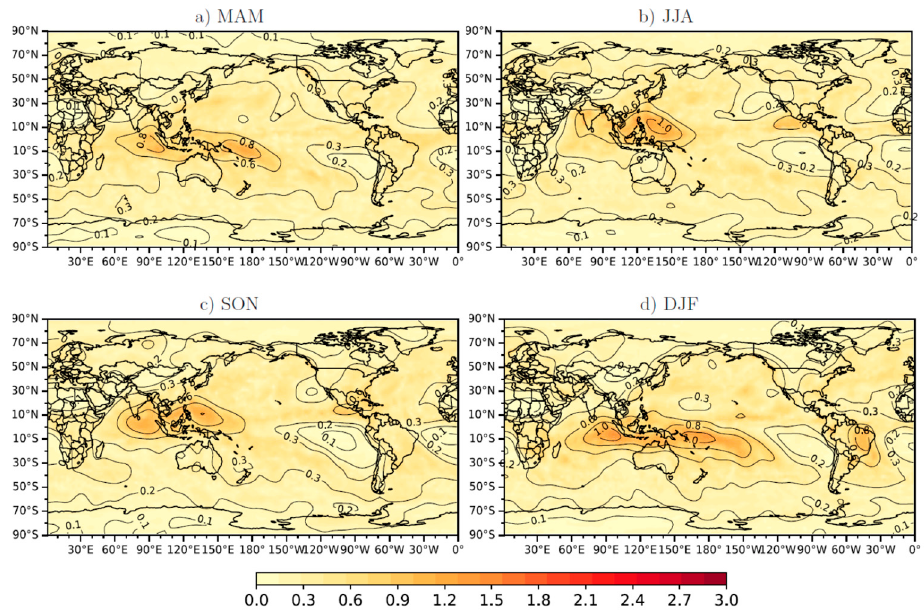
Figure 3. Unpredictable component standard deviation of GPCP precipitation (mm/day).